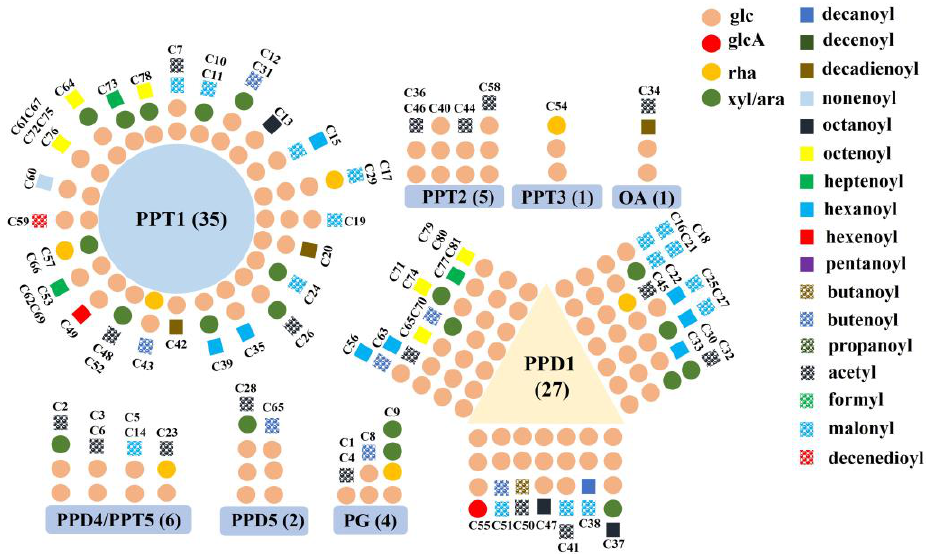
Figure 1. Schematic structures of the 81 new ginsenosides.